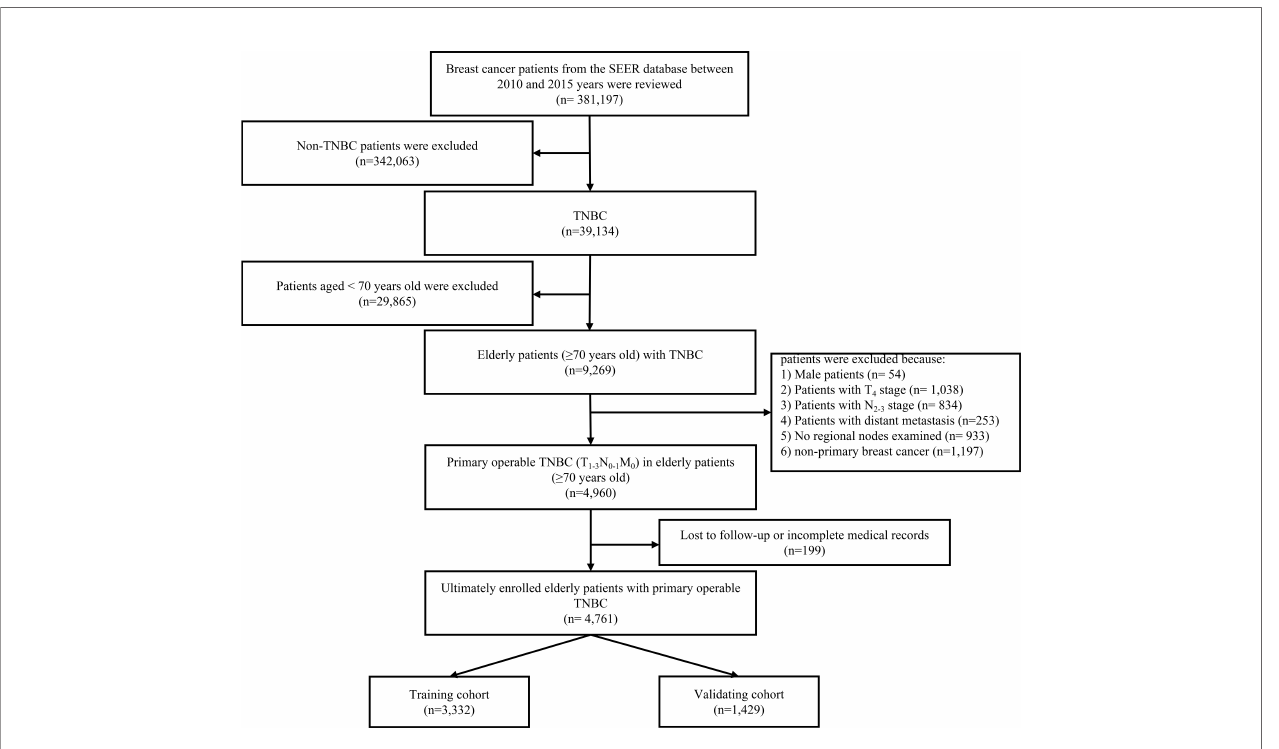
FIGURE 1 | The fl ow diagram of the patient selection process. TNBC, triple-negative breast